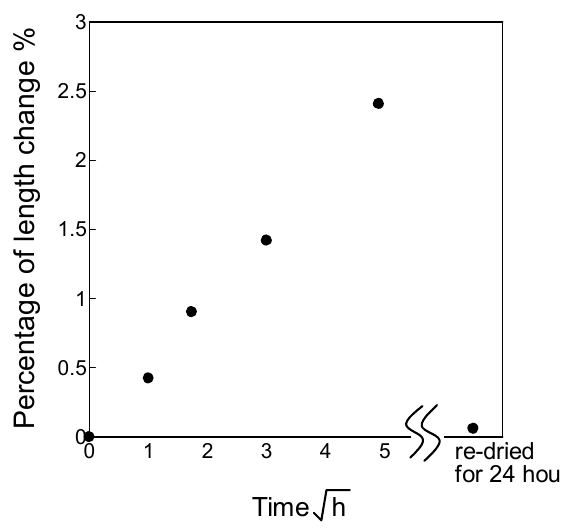
Figure 6. Length change of polyamide 6 by water absorption.